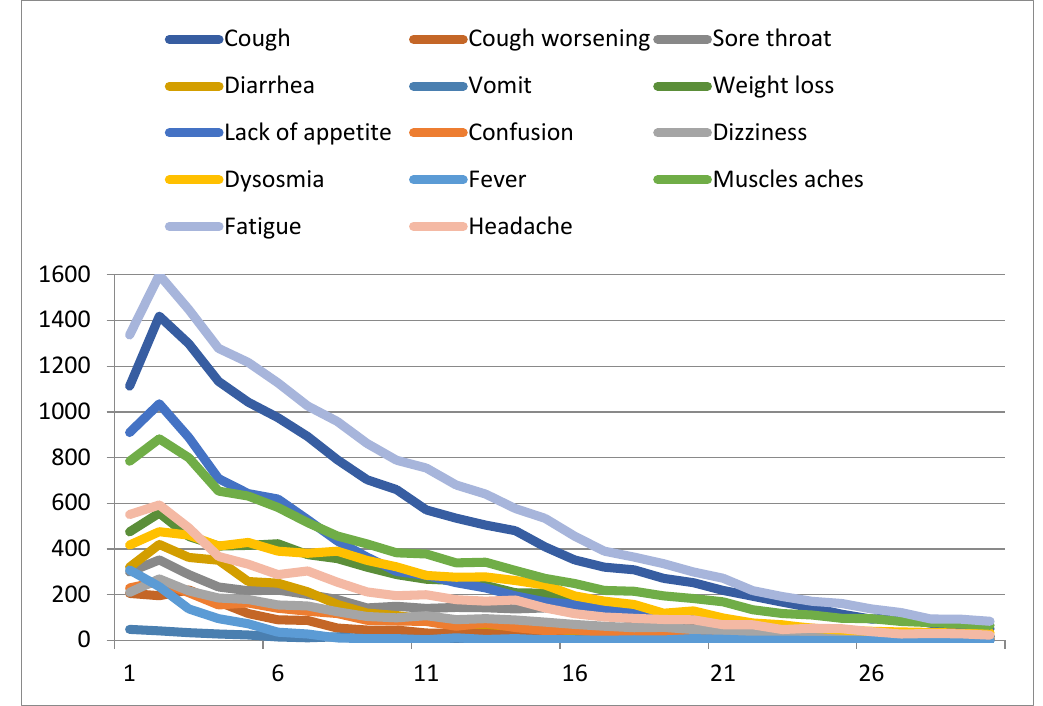
Figure 4. Number of reported symptoms per monitoring day.